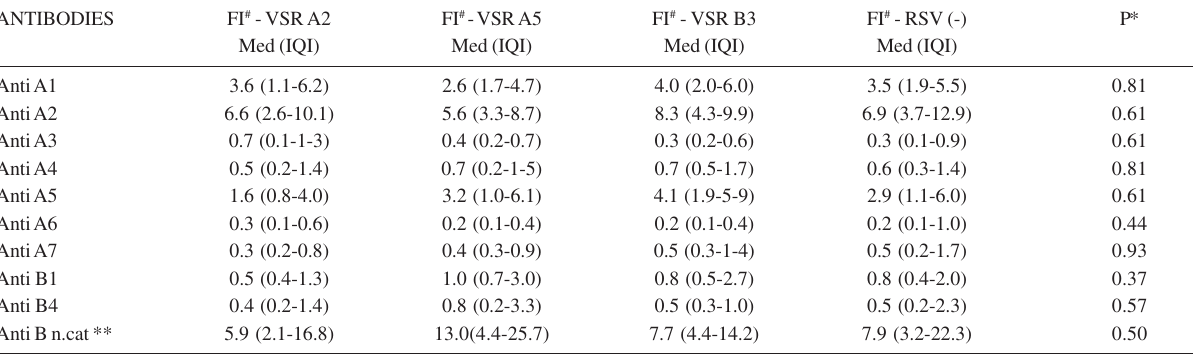
Table 4 - Estimates of the amounts of anti-RSV subtype-specific antibodies in the sera of infants with RSV GA2, GA5, GB3 and in the RSV(-) group.